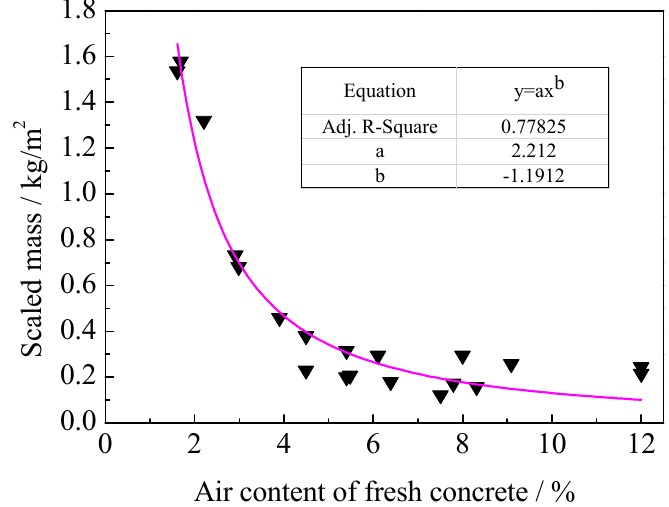
Figure 9. The relationship between the air content and the scaled mass of fresh concrete due to salt- frost.